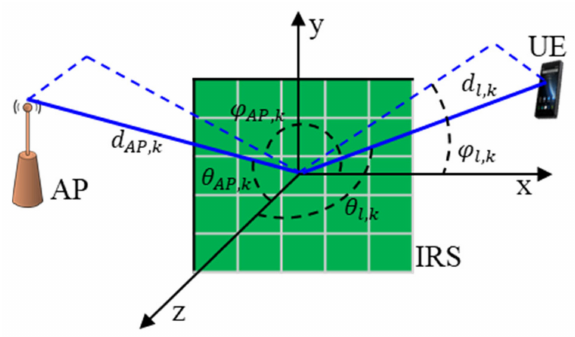
Figure 2. The configuration of intelligent reflecting surfaces